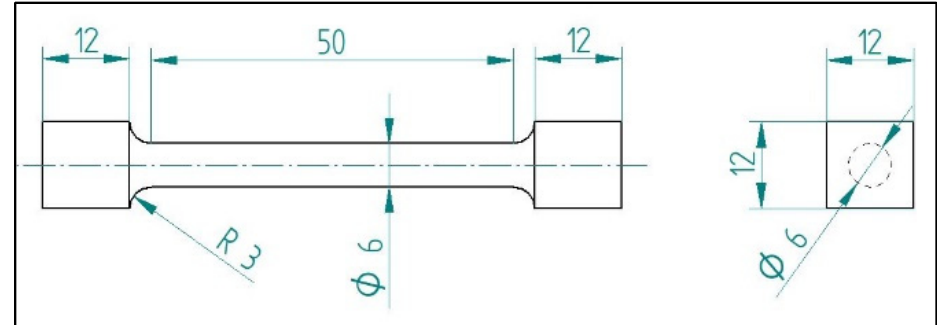
Figure 2. Schematic of torsion fatigue test specimens .